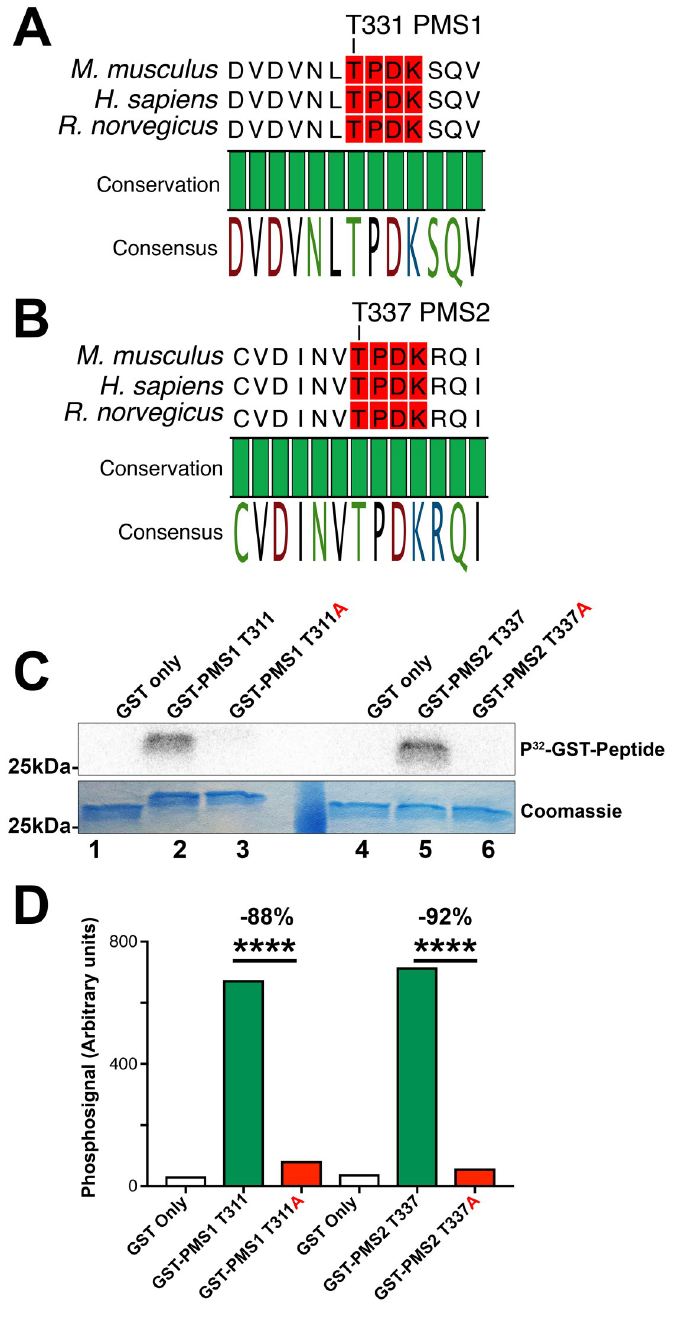
Fig 1. Potential CDK2 substrates; PMS1 and PMS2. Graphic representation of the evolutionary conservation of Thr331 and Thr337 in PMS1 (A) and PMS2 (B), respectively. Amino acid positions are labelled relative to the transcripts from Mus musculus . The CDK consensus site in each sequence is highlighted in red. (C) CDK2/cyclin A2 kinase assays directed against GST-tagged fusion peptides of PMS1 Thr331 (lane 2) or PMS2 Thr337 (lane 5) or their threonine-alanine point mutants (lanes 3 and 6, respectively). GST tag without fusion peptide are shown in lanes 1 and 4 as negative controls. Upper panel shows the phospho-image of each peptide and represents the amount of radiolabelling occurring following phosphorylation by CDK2/cyclin A2. The lower panel shows the Coomassie staining of radiolabelled proteins to indicate equal loading in each lane. (D) Phospho-image quantification of peptides from panel A. Data is presented as the absolute level of phosphorylation observed in each peptide as determined by densitometry analysis. Significance is determined by the difference in quantified phospho-signal by unpaired-T test. This experiment was repeated at least three times with similar results observed in each